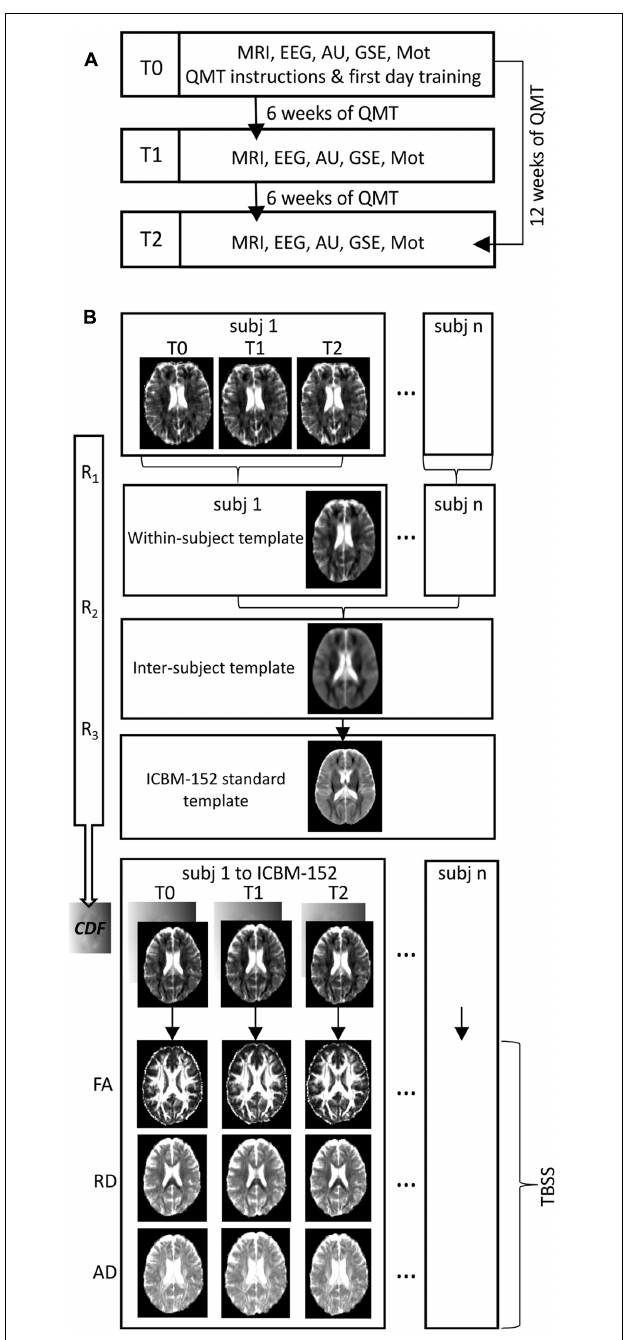
FIGURE 1 | (A) Flowchart of the experiment. A schematic representation of the longitudinal organization of the experimental procedure over time (MRI, Magnetic Resonance Imaging scanning; EEG, Electroencephalographic recordings; AU, Alternative Uses task; GSE, General Self Efficacy scale; Mot, Motivation scale). (B) Flowchart of processing pipeline for longitudinal diffusion tensor imaging analysis (R 1 , R 2 , R 3 : iterative processes of rigid, affine and non-linear diffeomorphic registrations; CDF: combined deformation field that define the mapping from subject-space to within-subject template, within-subject template to inter-subject template and inter-subject template to ICBM-152 standard template; FA, fractional anisotropy; RD, radial diffusivity; AD, axial diffusivity; TBSS, Tract-based Spatial Statistics).